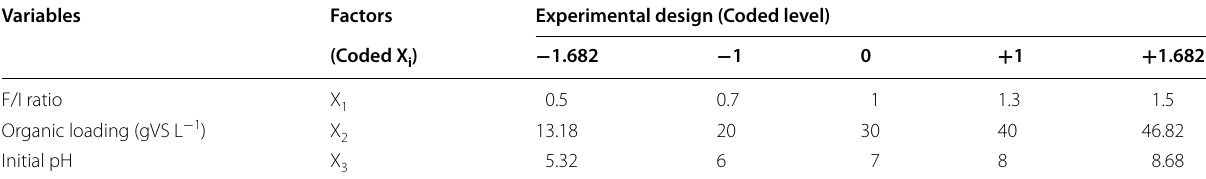
Table 2 The level of variables Variables Factors